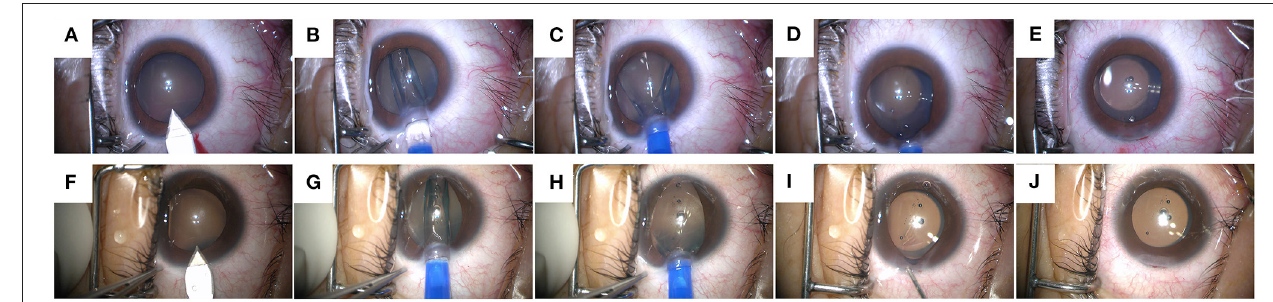
FIGURE 1 | The surgical steps of Implantable Collamer Lens V4c implantation with an ophthalmic viscosurgical device-free (OVD-free) technique. Case 1 (A–E) : (A) Incision creation. (B–D) ICL-V4c injection and placement. (E) The status at the end of the surgery. Case 2 (F–J) : (F) Incision creation. (G,H) ICL-V4c injection and placement. (I) Balanced salt solution injection. (J) The status at the end of the